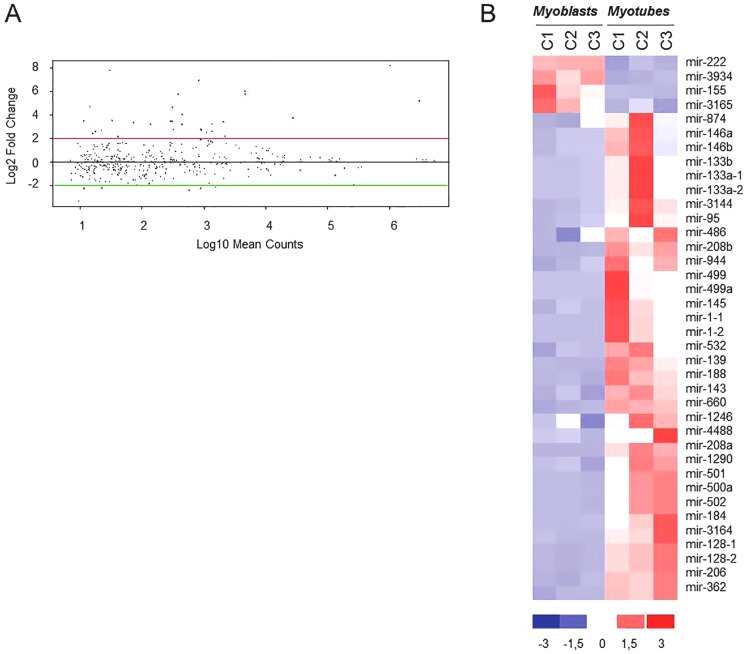
MiRNA modulation in control myogenesis.A) DEseq analysis of miRNAs differentially expressed in control myotubes vs control myoblasts (control differentiation). MiRNAs showing a modulation with log2FC≥2 and a p-value<0.05 are shown as red dots. B) Hierarchical clustering of the 38 modulated miRNAs (34 up-regulated and 4 down-regulated) in regard to the analyzed samples. C1:MX01010MBS; C2: MX03609MBS; C3: MX01110MBS, Control cell lines (see Table S1).